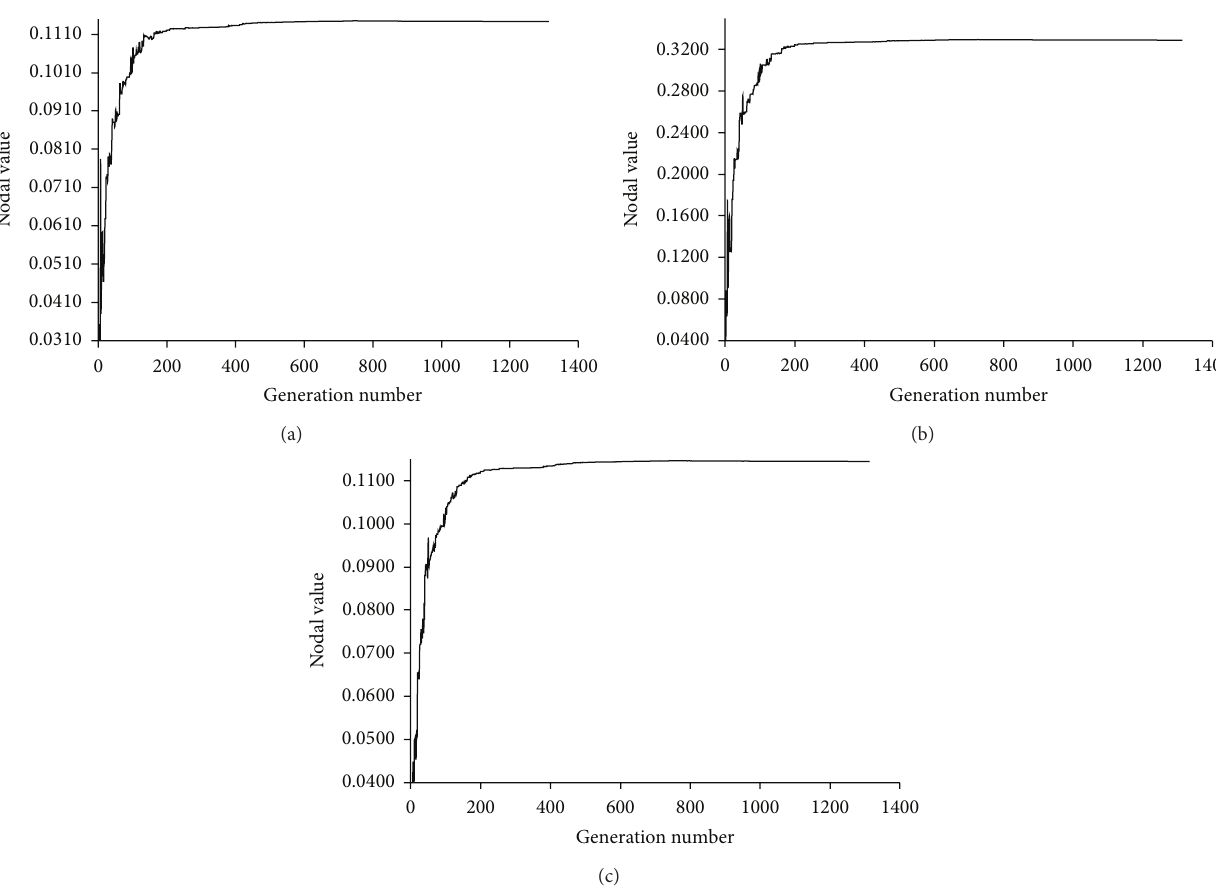
Figure 5: Evolution of the nodal values for Bratu’s problem when 𝜇 = 2 for (a) 𝑦(𝑥 1 ) , (b) 𝑦(𝑥 5 ) , and (c) 𝑦(𝑥 9 )